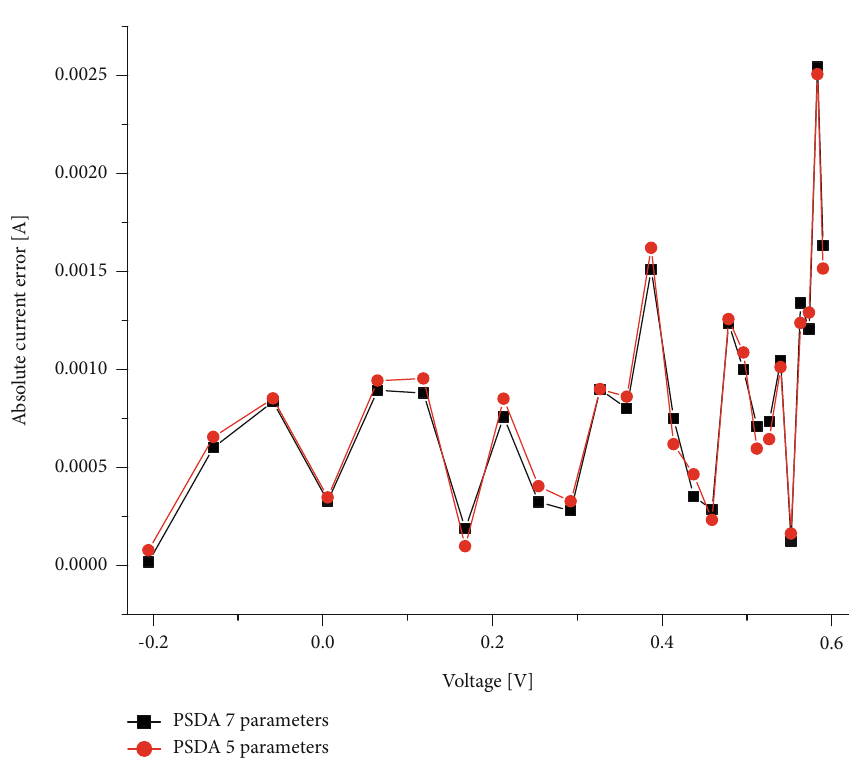
Figure 6: Comparison between the two-diode and one-diode model for STE 4/100